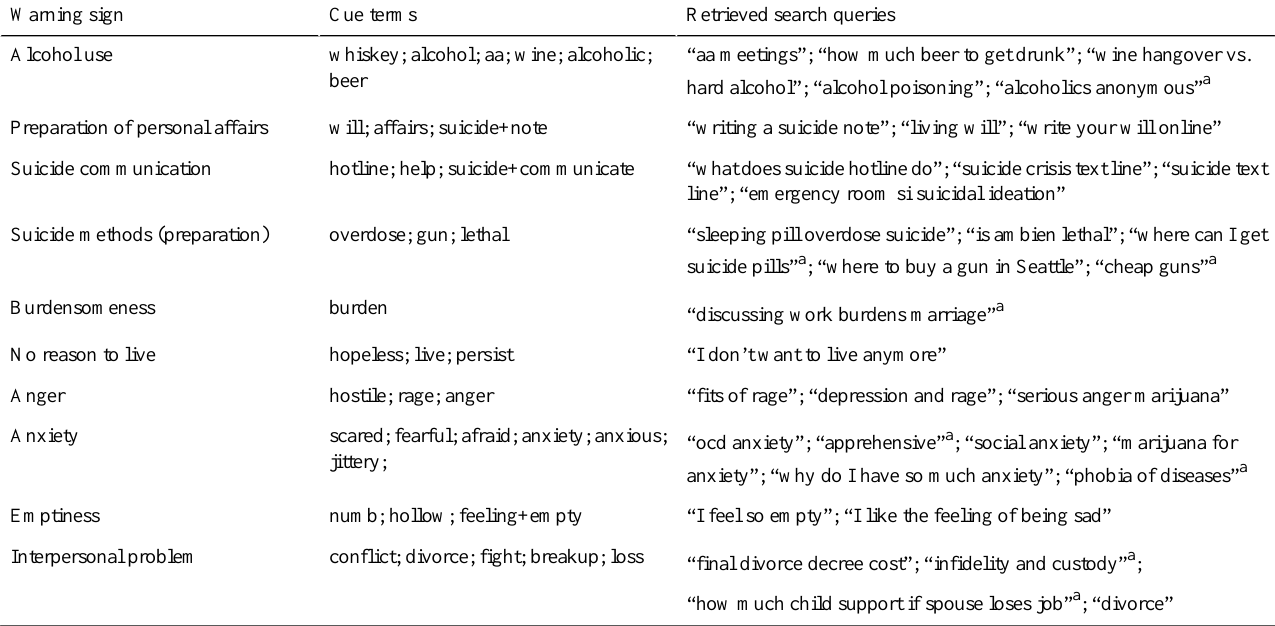
Retrieved search queriesCue termsWarning